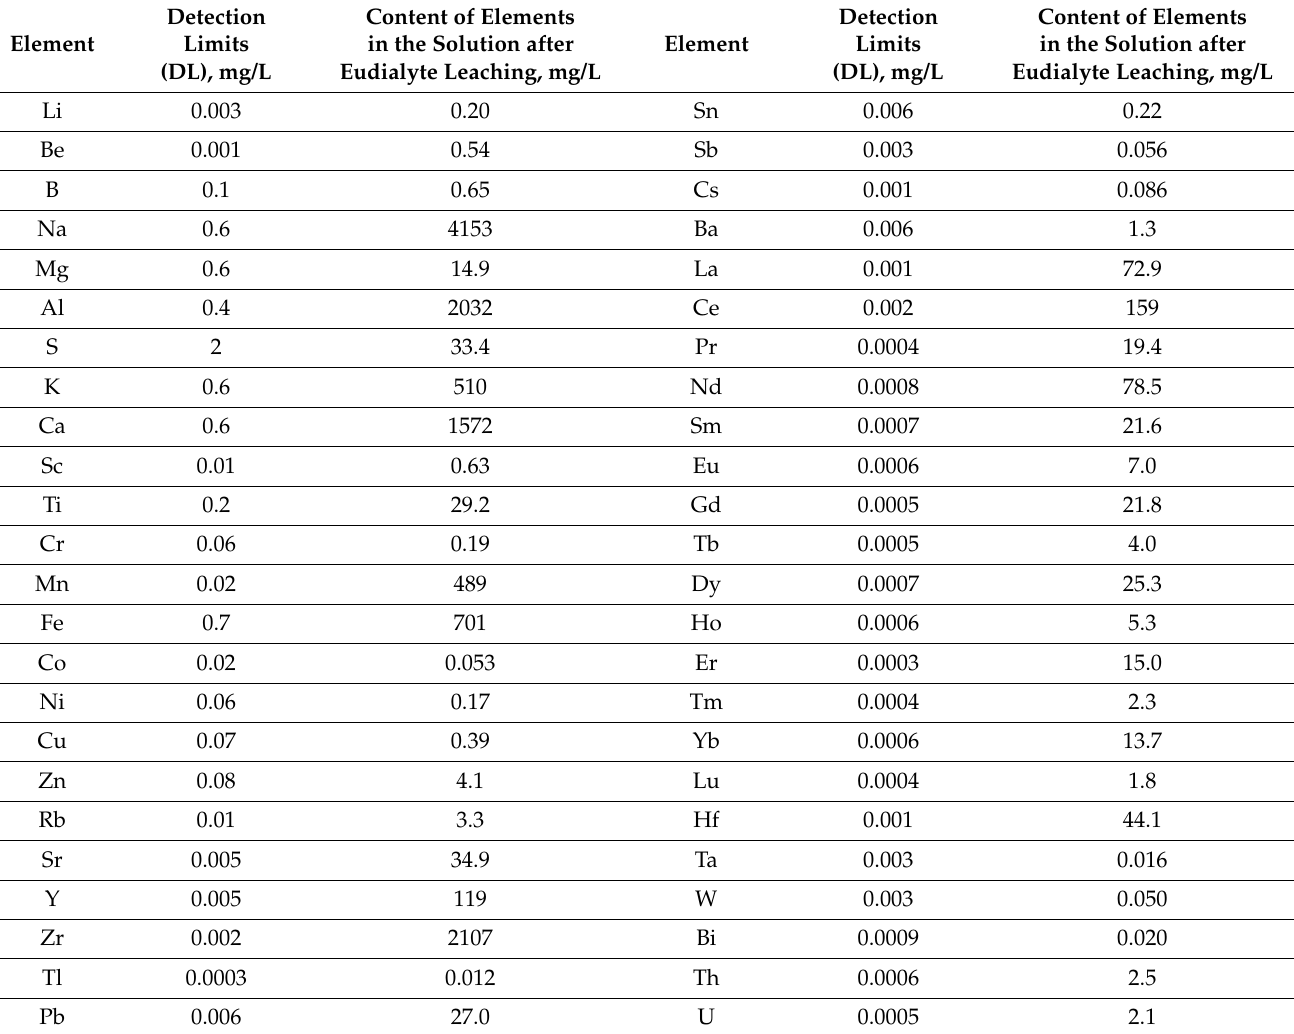
Table 4. Elemental content in the solution after the leaching of a eudialyte ore